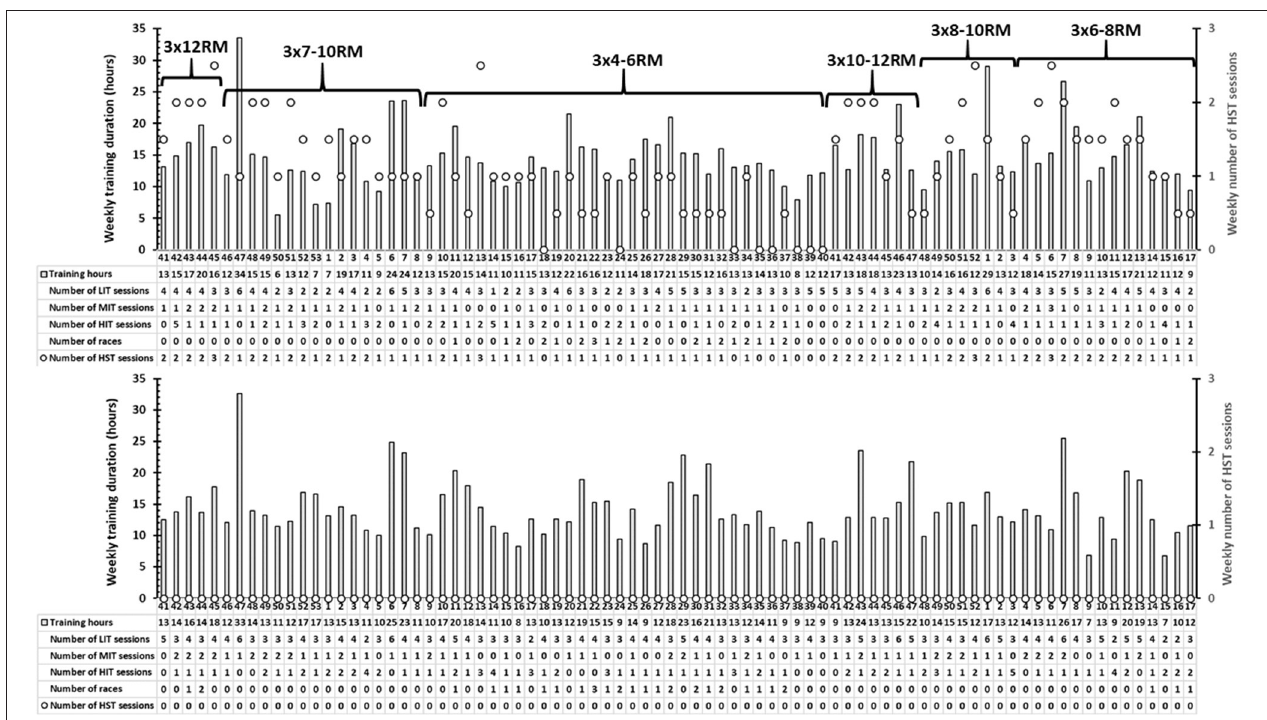
FIGURE 1 | Mean weekly training duration (bars, y1-axis), mean weekly number of heavy strength training sessions (circles, y2-axis), weekly mean number of low-intensity training (LIT) sessions, moderate-intensity training (MIT) sessions, and high-intensity interval training (HIT) sessions, and distribution of sets and repetitions of the strength training for the two cyclists starting with heavy strength training ( EandS1 and EandS2; upper panel) and for the two cyclists continuing endurance training only ( E; lower panel). Data start with the preparatory period via the competition period and the new preparatory period, and conclude at the start of the following competition period (i.e., 1.5